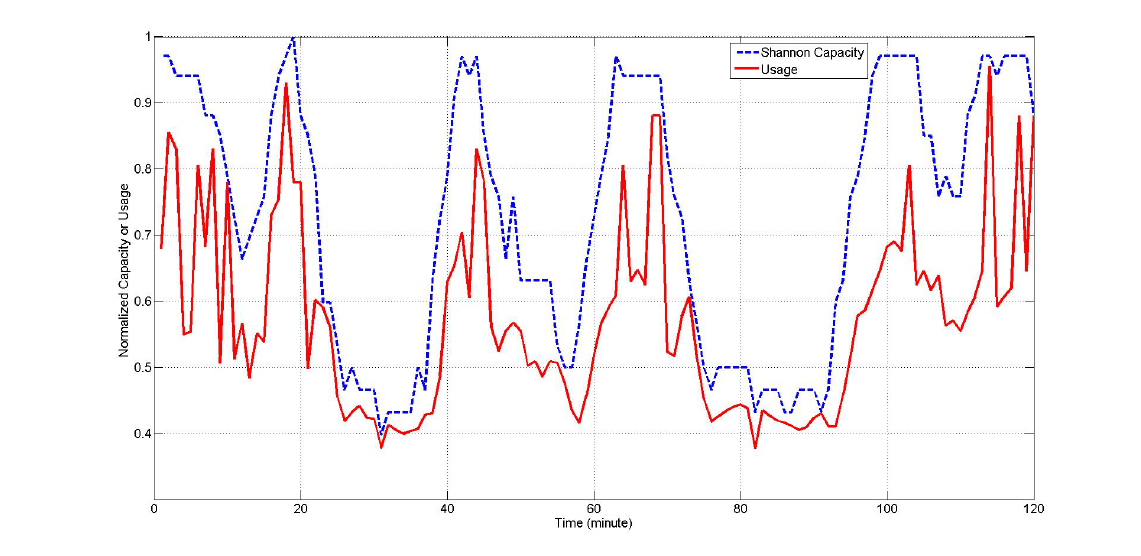
Figure 6. Comparison between the normalized channel usage with channel capacity prediction based on the algorithm in Method 3 with N = 3 and capacity with respect to